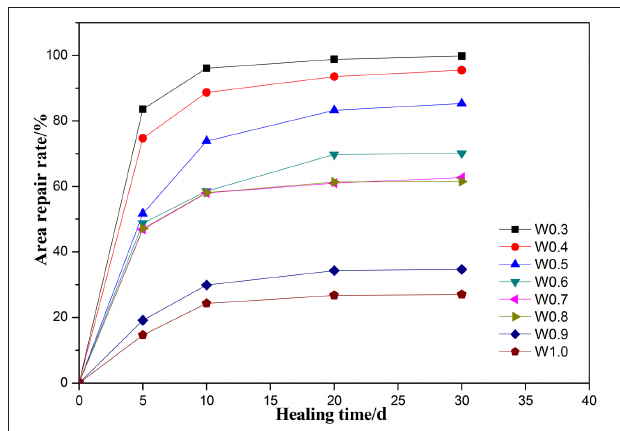
FIGURE 10 | The average area repair rate of specimens with different crack width.